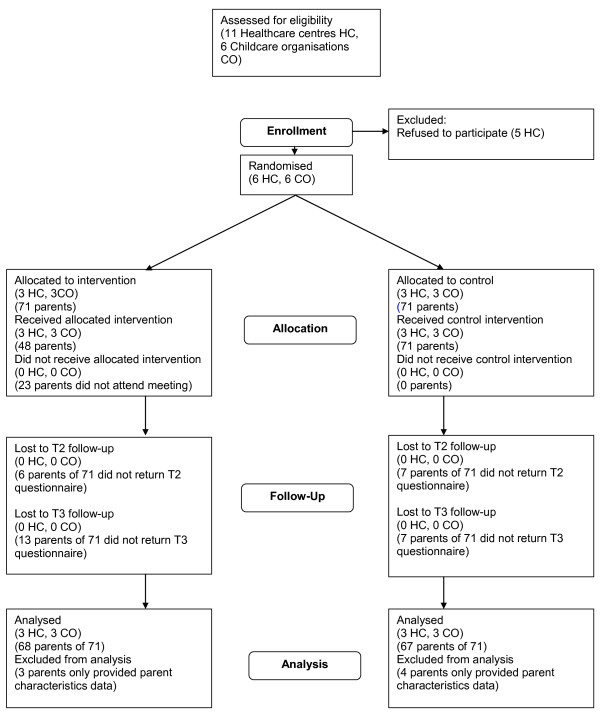
Participant flow.